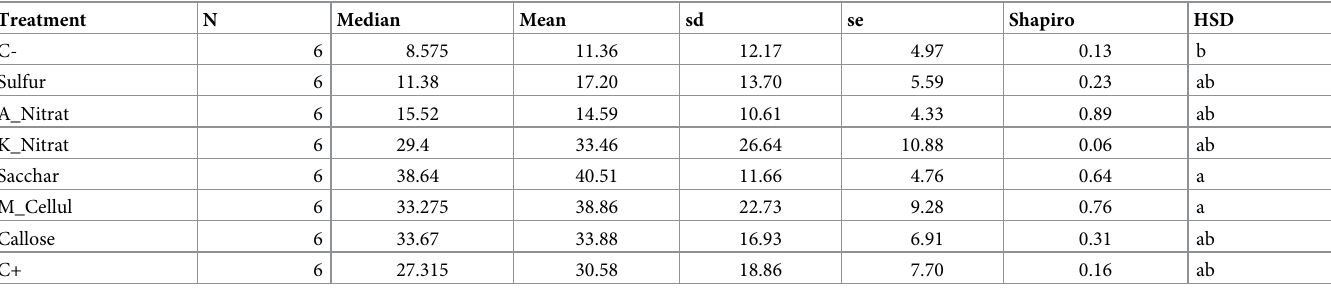
Table note: sd, standard deviation; se, standard error; Shapiro, p-value for the Shapiro-Wilk normality test, a p-value below 0.05 indicates non normal distribution; HSD, Tukey’s Honestly Significant Difference test, where different letters depict statistically significant differences in the ANOVA Tukey post hoc test for alpha � 0.05 (F-value = 2.56; p-value = 0.028). Shapiro test for residuals = 0.0511, Levene p = 0.391, data meet normality and homoscedasticity